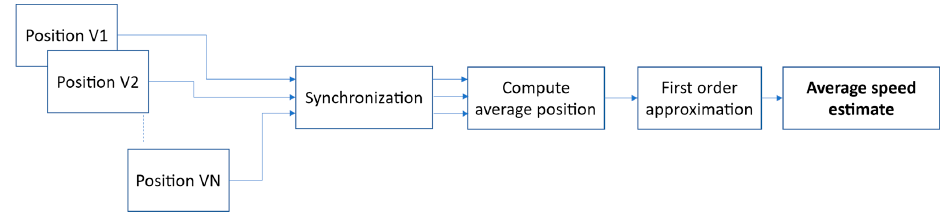
10 of 19 Figure 7. A block diagram of the average vehicle position estimation.